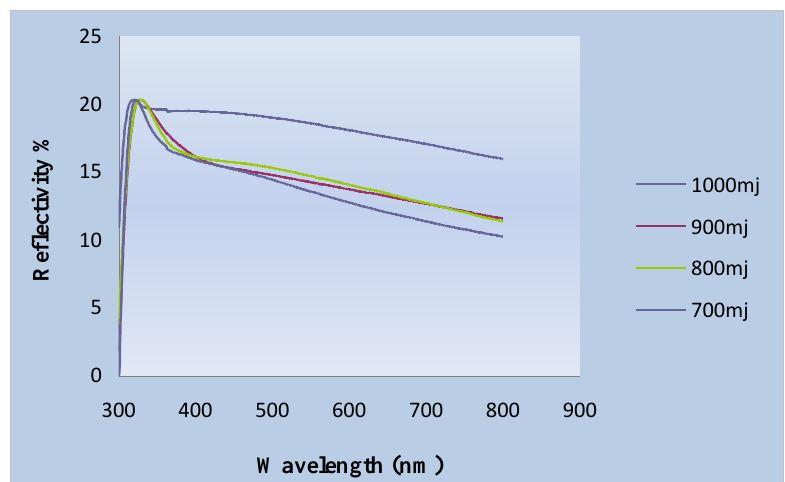
Fig.4: Optical reflectivity as a function of wavelength for ZnS/glass at different laser